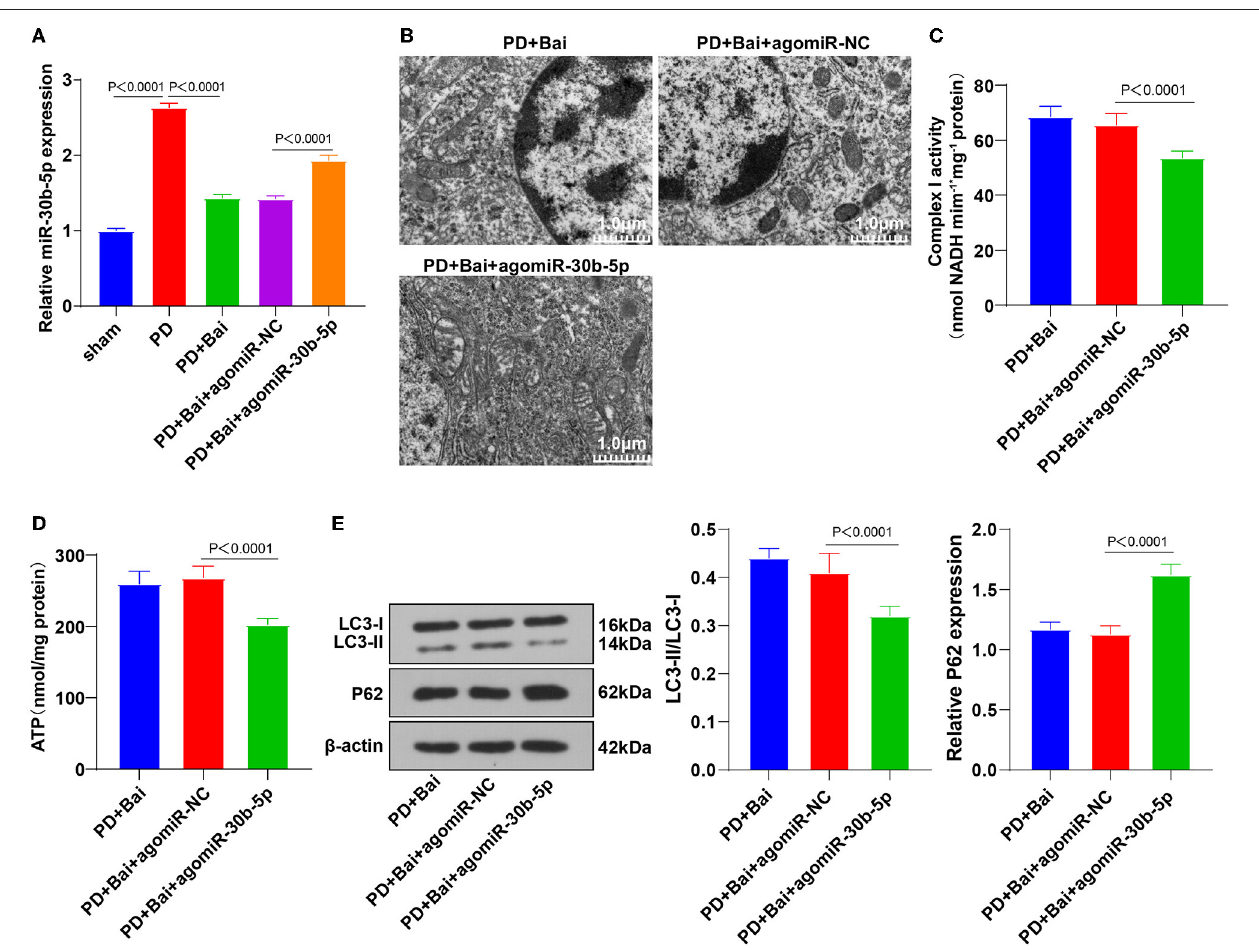
FIGURE 2 | Upregulation of miR-30b-5p reversed the promotive effect of baicalein on mitochondrial autophagy. The agomiR-30b-5p was transfected into PD rats. (A) The expression of miR-30b-5p was detected by RT-qPCR; (B) the ultrastructure of mitochondria was observed using a TEM; (C,D) the activities of mitochondrial complex I and ATP were detected using kits; (E) the levels of autophagy marker proteins LC3-II/I and p62 were detected by WB. N = 6. The data in the figure are all measurement data and expressed as mean ± standard deviation; one-way ANOVA was used for variance analysis among multigroups; Tukey’s multiple comparisons test was used for the post hoc